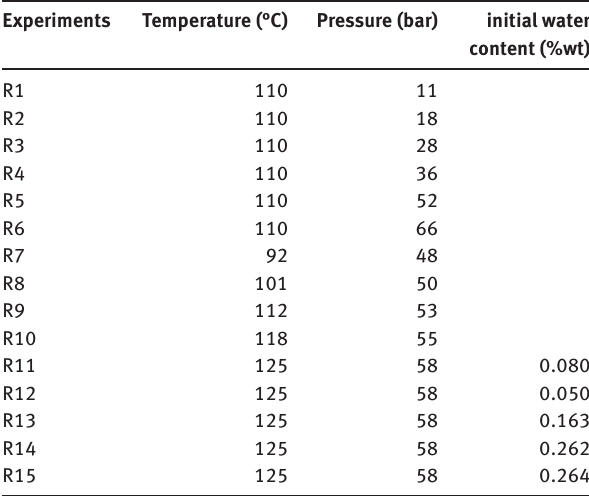
Table 1: Experimental conditions for reactions of carbonation of ethanol with 2 g of CeO during 24 h. 2